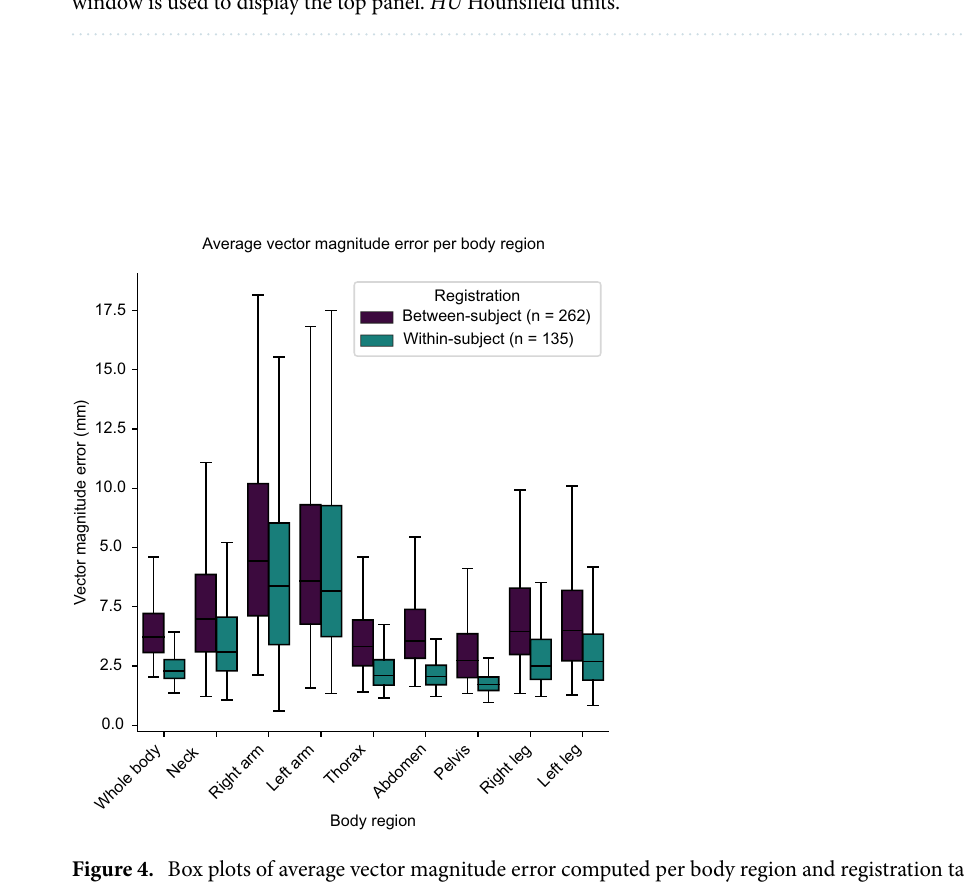
Figure 3. Mid-coronal planes of voxel-wise CT statistics of images registered to template spaces. Each panel shows the results from registered female cHL images, male cHL images, female HNC images and male HNC images from left to right. The number of subjects in each subset is shown below the bottom figure. A soft tissue window is used to display the top panel. HU Hounsfield units.